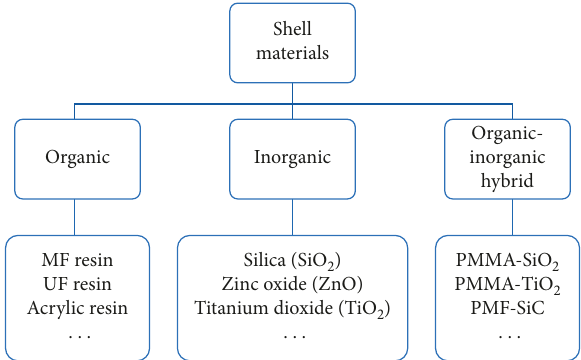
Figure 2: Shell materials of microencapsulation for